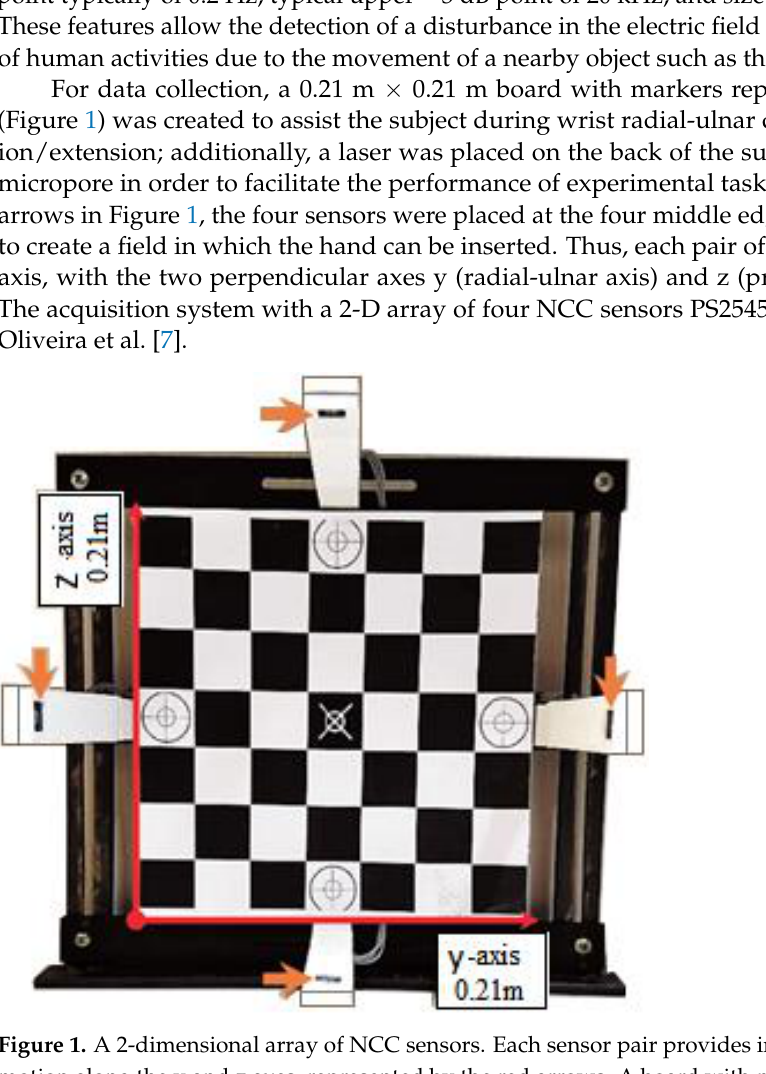
4 of 20 Table 1. Comparison between the mean age of PD and HS groups. Group Mean Age Shapiro-Wilk p -Value ( t -Test) PD